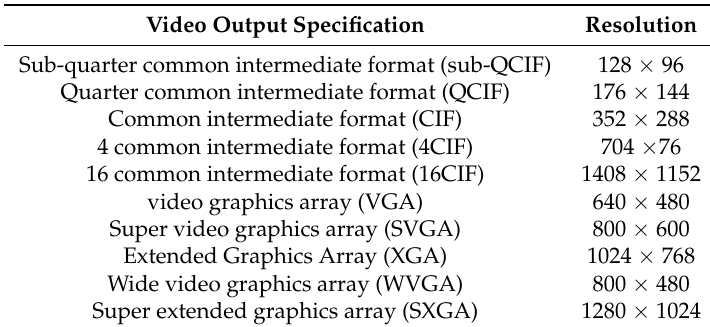
Table 1. Common video